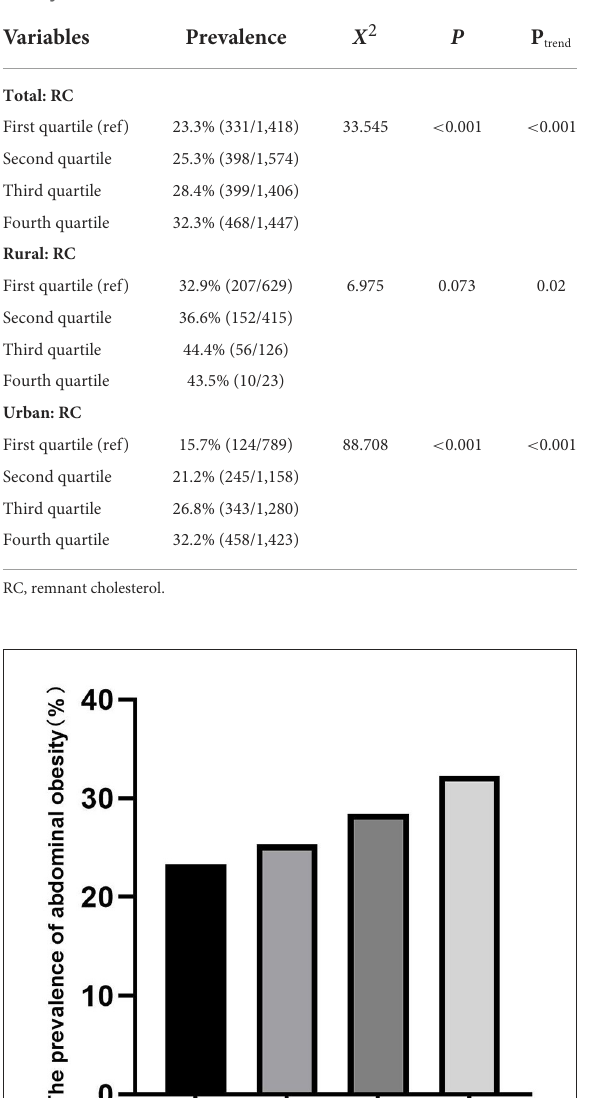
TABLE 2 The prevalence of children with abdominal obesity aged 6–12 years.